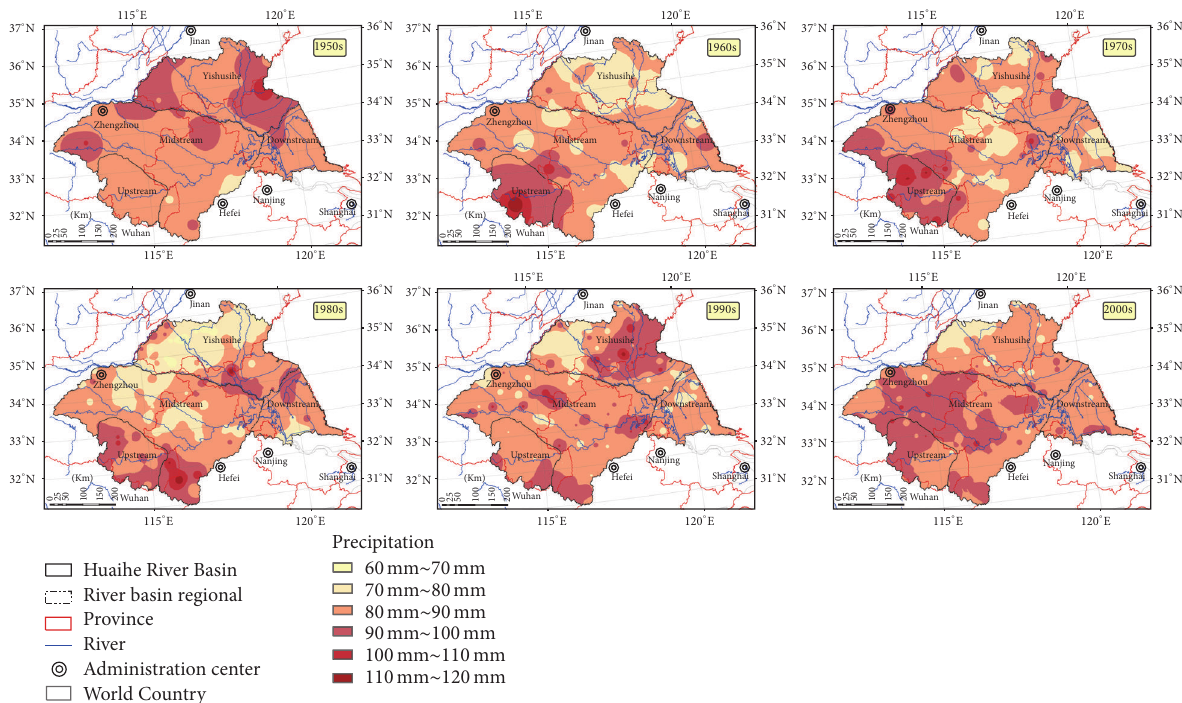
Figure 7: Spatial distribution of isolated rainstorm event precipitation during 1950s–2000s.